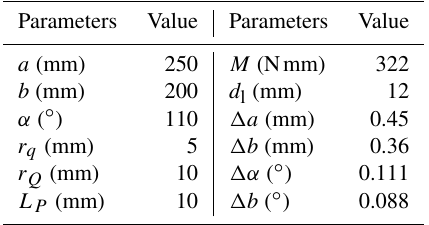
Table 1. Related parameters of the Bennett